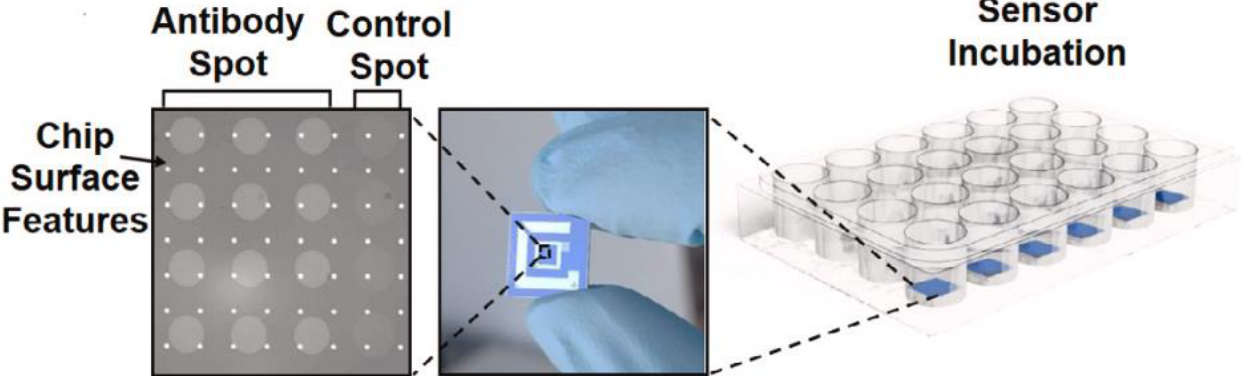
Figure 8. Schematic representation of new generation. ( A ) IRIS chip; ( B ) Si-based IRIS cartridge [49]. Reproduced with permission from A.Y. Ozkumur, F.E. Kanik, J.T. Trueb, C. Yurdakul, M.S. Ünlü, IEEE Journal of Selected Topics in Quantum Electronics; Published by IEEE, 2019.